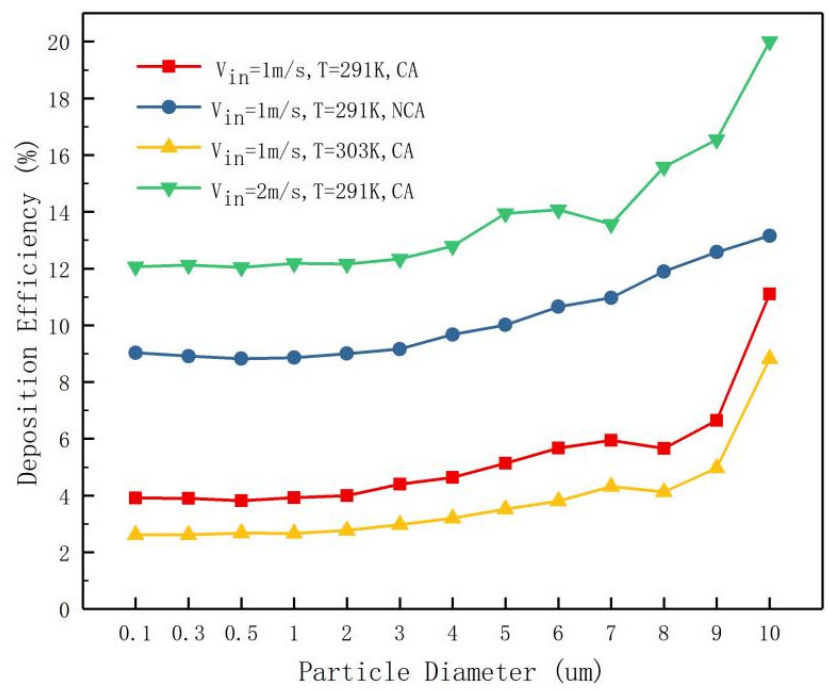
Figure 9. Windvelocity, temperature, andrespiratorytracteffectonparticulatedepositionininfectedhumans. Figure 9. Wind velocity, temperature, and respiratory tract effect on particulate deposition in in ‐ fected humans. Figure 10 reflects the frequency distribution of 0.3 µ m particles in different directions on the exit surface for different ambient temperatures, different ambient velocities, and in the absence of the respiratory tract. RF is defined as: m deposition , d RF = where m deposition , d is the number of particles deposited with a diameter of 0.3 µ m per 0.15 m intervals in the x or y direction on the exit surface, and m total , out is the total number of particles deposited on the exit